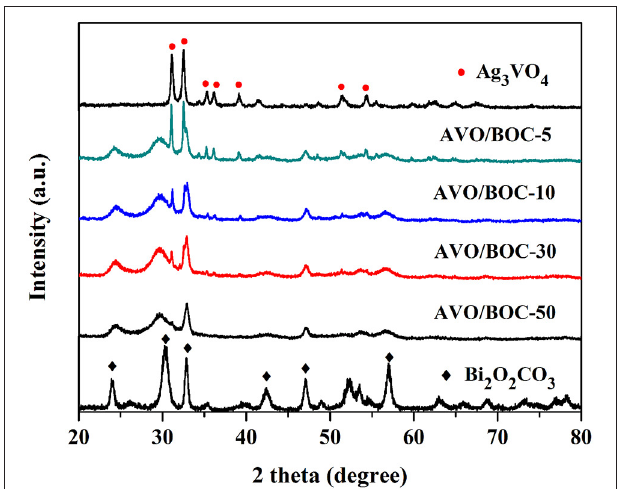
FIGURE 1 | XRD patterns of Ag 3 VO 4 /Bi 2 O 2 CO 3 heterojunctions (AVO/BOC-5, AVO/BOC-10, AVO/BOC-30, and AVO/BOC-50), pure Bi 2 O 2 CO 3 , and Ag 3 VO 4